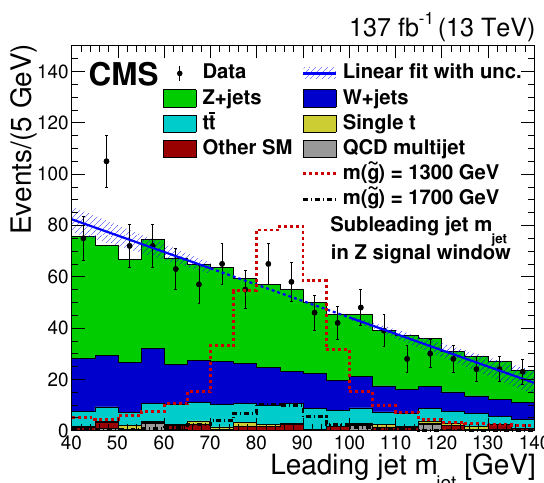
Figure 4 . Leading AK8 jet m shape (cid:12)t in the mass sidebands. The Z candidate selection is jet applied and the subleading AK8 jet m value is required to lie in the Z signal window. The blue jet hatched region represents the (cid:6) 1 standard deviation uncertainty in the (cid:12)t to the mass sideband performed with a linear function, which is indicated by the blue line. The stacked histogram shows the background from simulation scaled to the data. Expected signal contributions for two example mass points are also